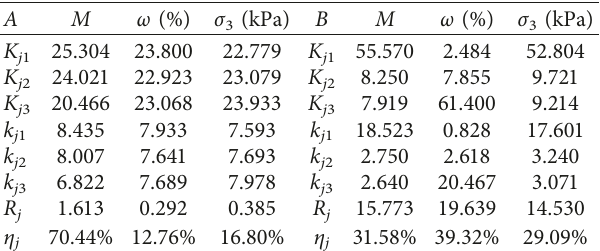
Table 3: Orthogonal test results. K the row level m repeated tests for the j line factor. k jm is the average value of the parameters. R j is the range (i.e., the difference between the maximum and minimum) of k jm . η j